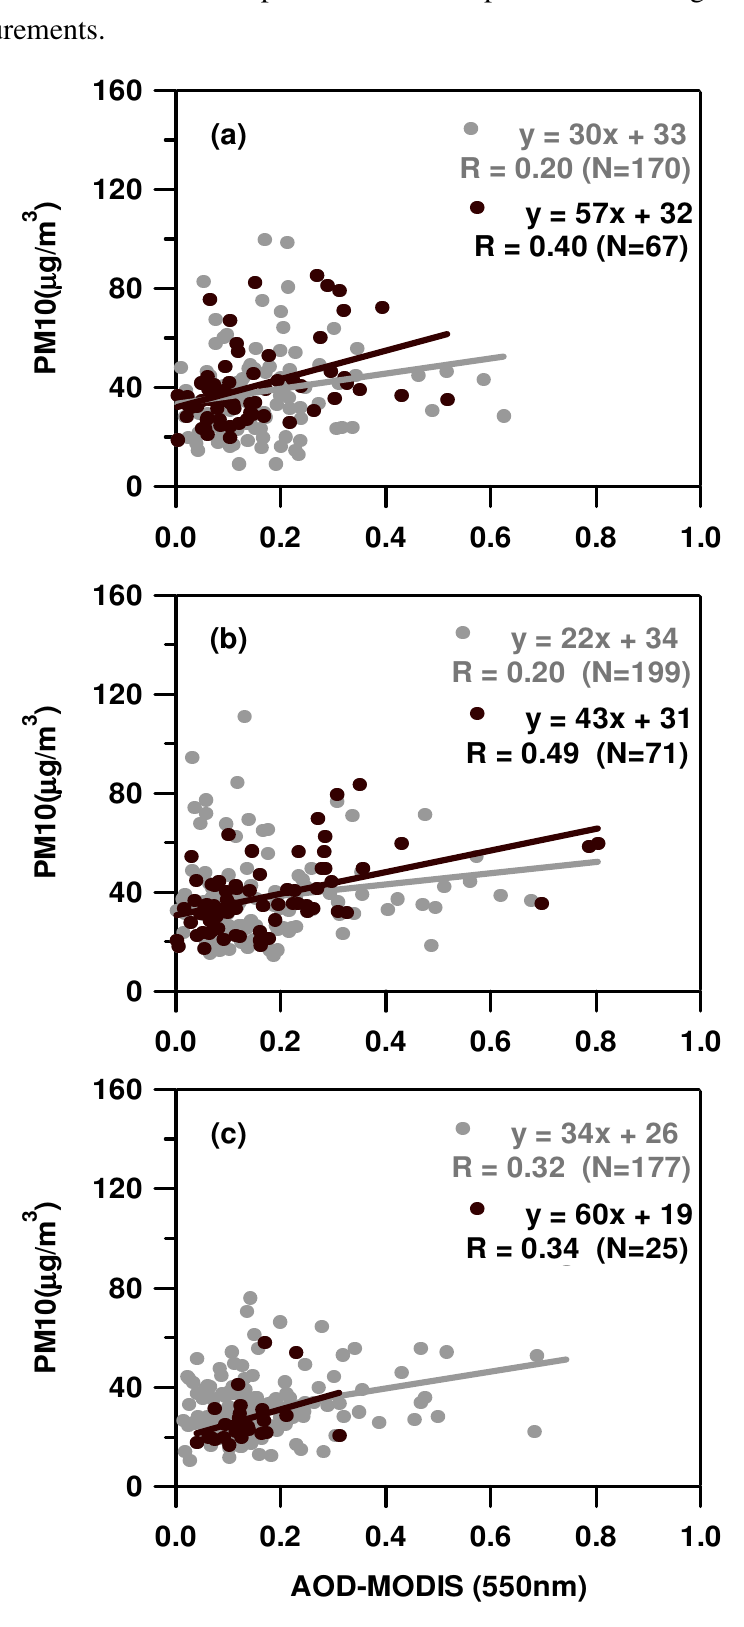
Figure 5. Scatterplot of PM10 mass concentrations versus co-located in space MODIS-AOTs at Arnesano for (a) 2006, (b) 2007, and (c) 2008. Slope, intercept and linear correlation coefficient ( R ) are also given in each plot, in addition to the total number of data points ( N ). Black dots represent data points referring to clear-sky MODIS measurements.